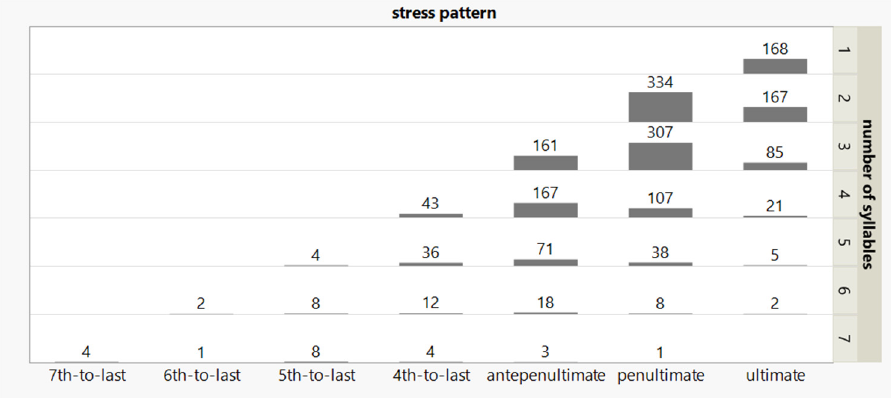
Figure 1. Stress patterns per number of syllables within the prosodic word (adapted from Andreeva et al. 2019).